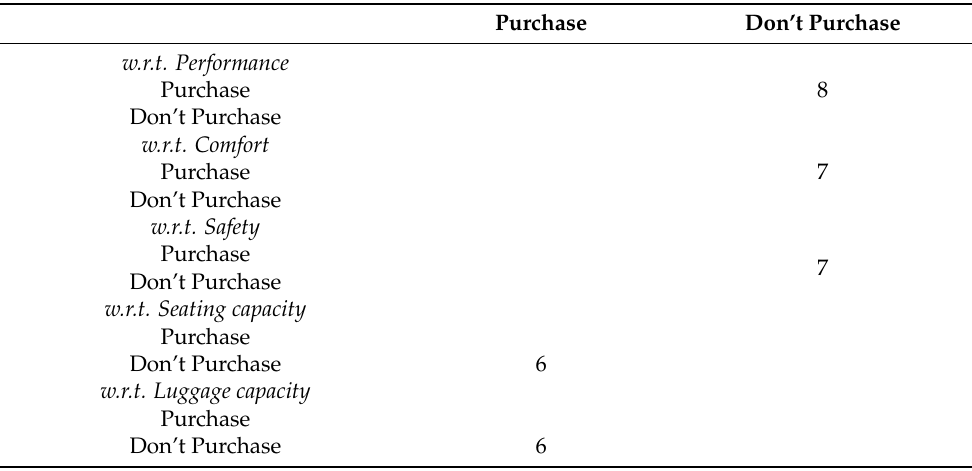
Table 12. Pairwise comparison matrix of Purchase and Don’t Purchase decision with respect to sub-criteria of FUNCTIONALITY.